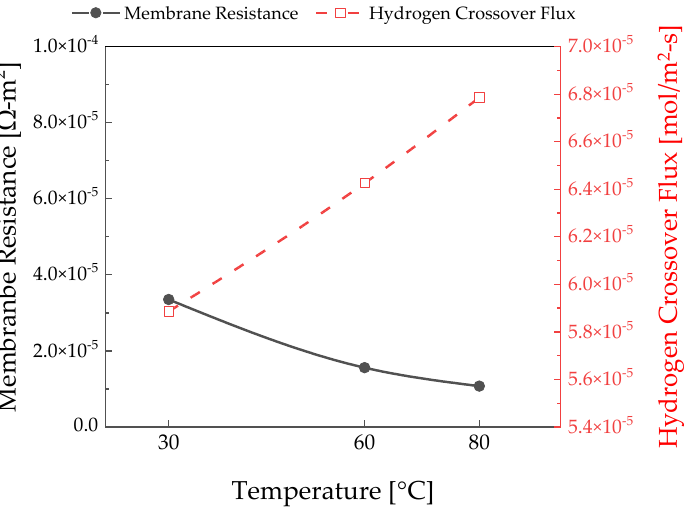
Figure 6. Polymer electrolyte membrane resistance and hydrogen crossover flux according to the temperature measured at 0.18 V.